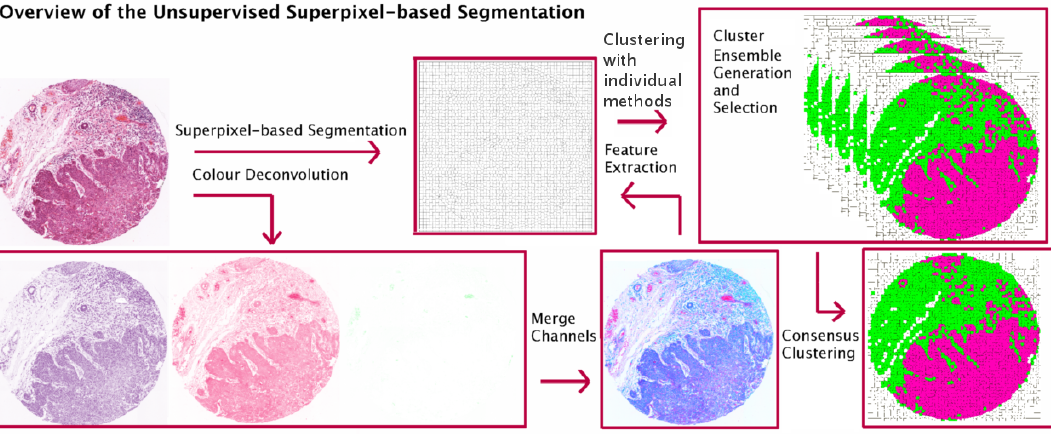
Figure 1. Block-diagram with an overview of the unsupervised superpixel-based segmentation